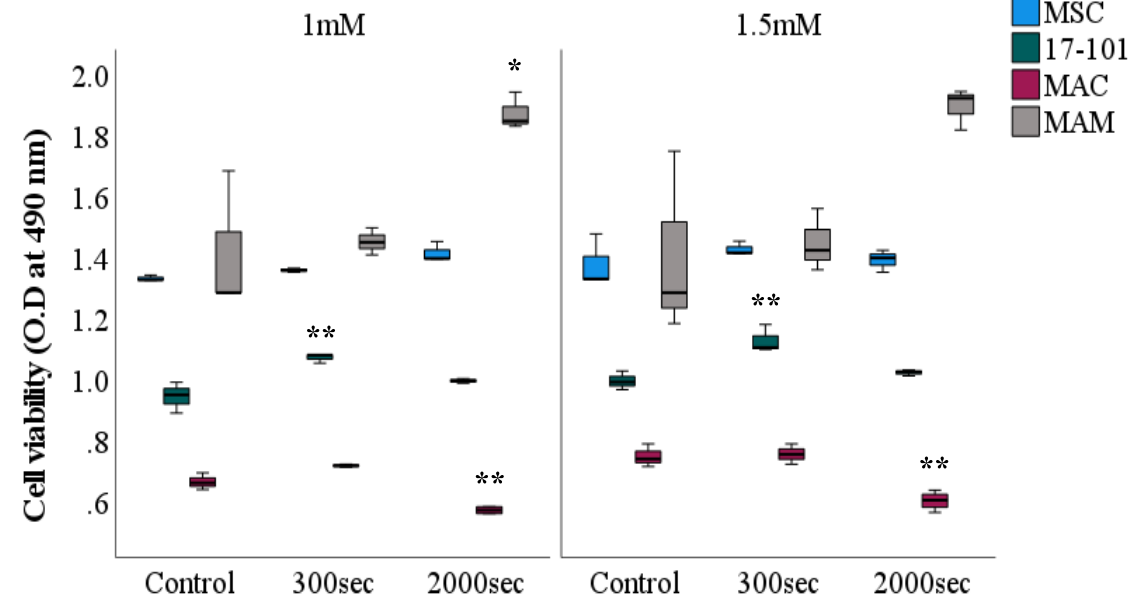
Figure 3. MTS—viability assessment of bone metastases cell lines after PDT exposure . All cell lines (17-1012—giant cell tumor of bone, MAC—bone metastases of invasive ductal breast carcinoma, MAM—bone metastases of renal cell carcinoma, and MSC as a control) were subjected to PDT exposure for predefined time frames of either 300 sec or 2000 sec. As a photosensitizer, 5-ALA was employed at two different concentrations: 1 mM (left side) and 1.5 mM (right side). Comparisons were conducted in relation to the control group (cells that were not subjected to PDT exposure). Data of 3 experiments performed in triplicates. * p < 0.05, ** p < 0.01. Abbreviations: 5-ALA—5-aminolaevulinic acid, O. D—optical density, sec—seconds.